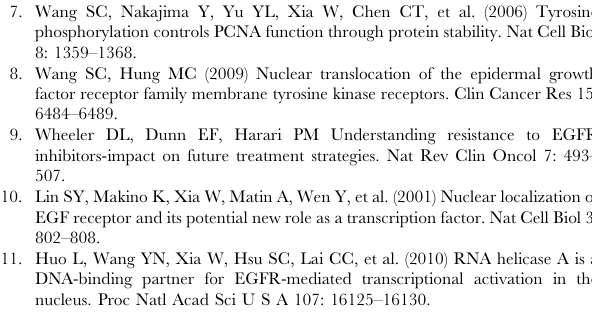
Figure S1 The effect of Y211F CPPP on tumor growth in vivo. (A) Approximately 1 6 10 7 MDA-MB 468 cells were subcutaneously injected into the flanks of nude mice. When the tumors were palpable, mice were randomly divided into 3 groups and treated with PBS (Control), scrambled peptide for Y211 (Scramble), or Y211F CPPP (200 nmol/mouse) by intratumoral injection. Tumor volume was measured the tumor volume at the indicated time point. (B) The weight of each of the harvested tumors was measured after treatment. The curves and bars indicate mean 6 S.D.; *, p , 0.05; **, p , 0.01; ***, p , 0.001 by t - test.